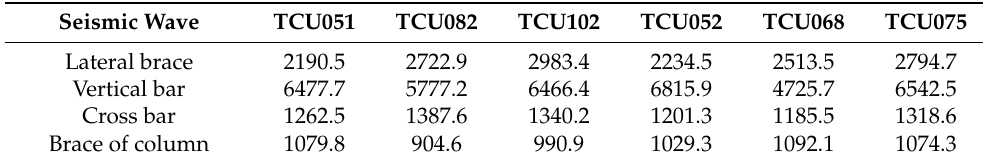
Table 5. Maximum axial force of members under frequent earthquakes